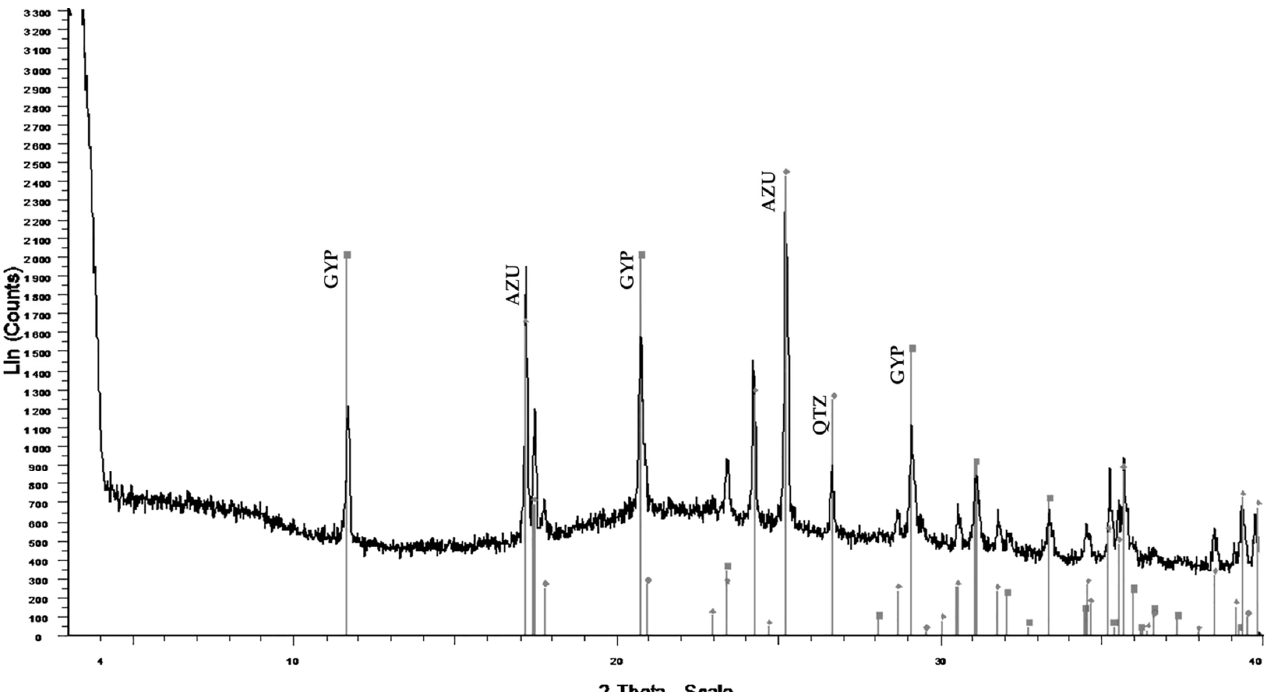
Figure 7. PD-V diffractogram showing azurite (AZU), gypsum (GYP), and quartz (QTZ) minerals.